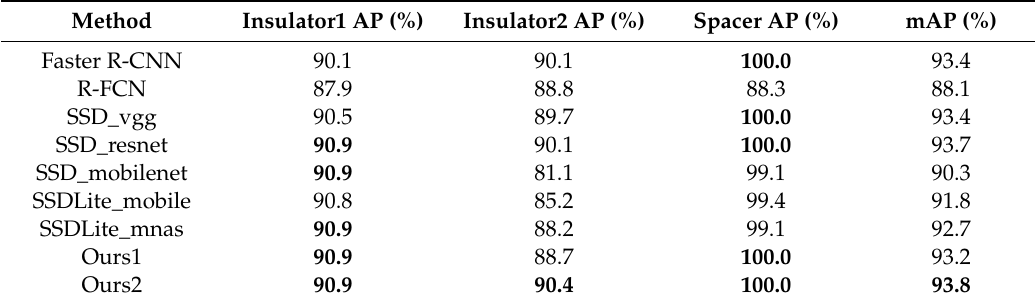
Table 3. Detection accuracy of di ff erent algorithms. Note that the best results are bold-faced.